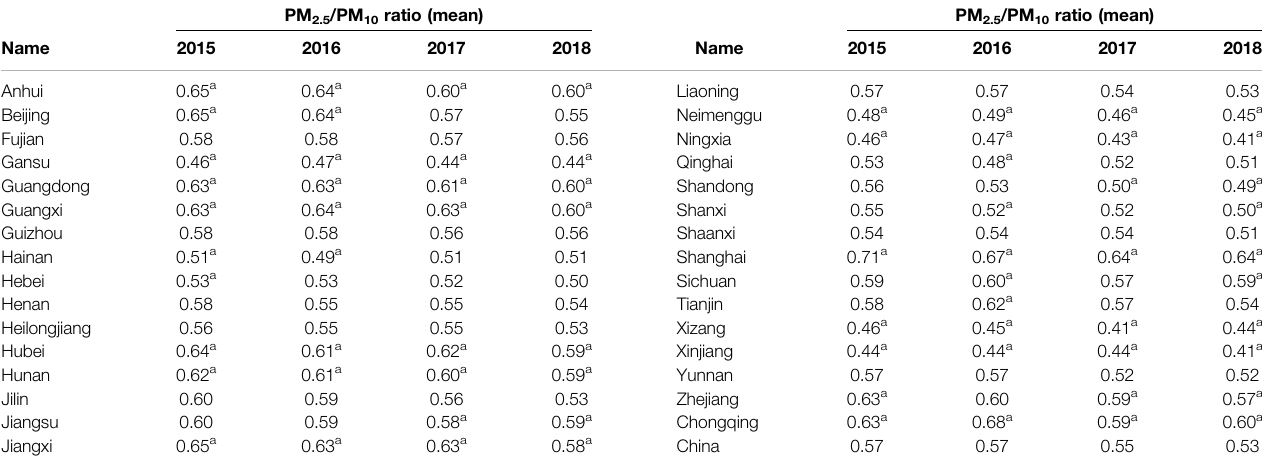
TABLE 1 | The changes in the ratio of PM 2.5 /PM 10 in each province and the country from 2015 to 2018.